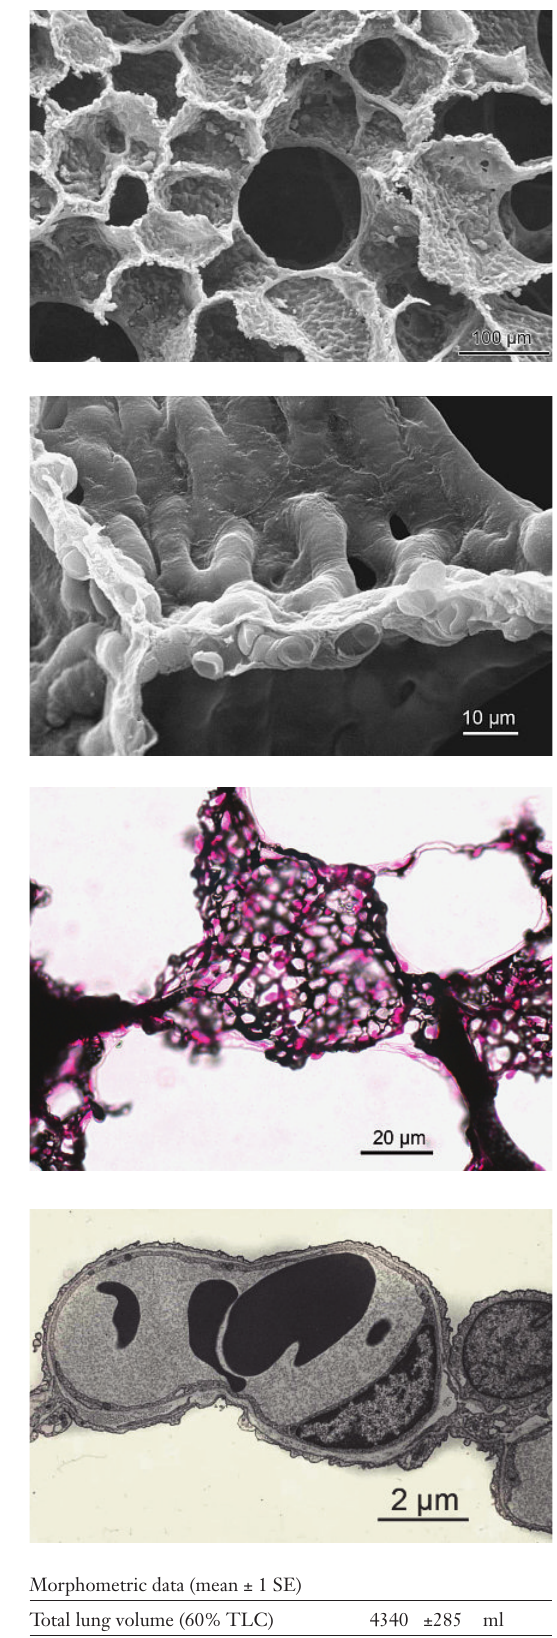
Morphometric esti- mate of DL O2 for young, healthy adult humans of 70 kg body weight, measuring 175 cm in height a